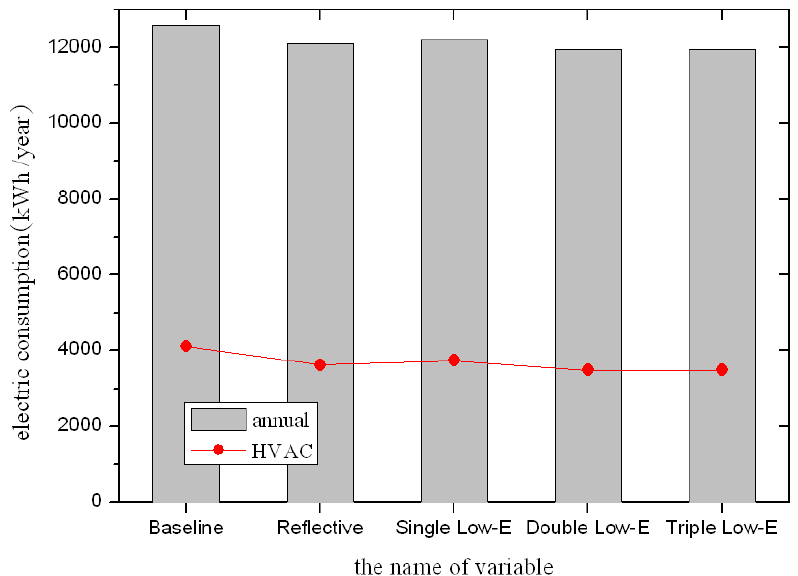
Figure 7. Comparison of annual energy consumption for different window